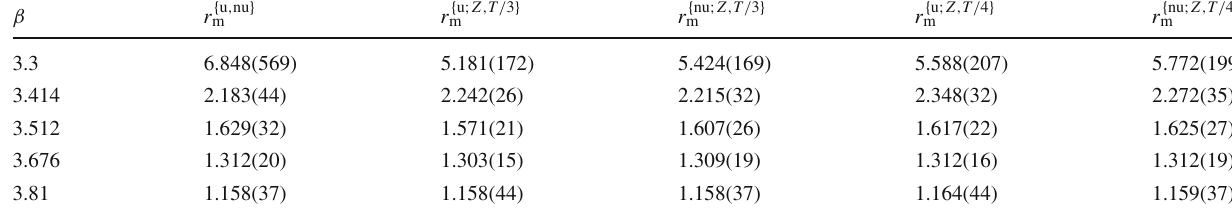
Fig. 6 Left: results for different r m estimates as reported in Table 4. The results for β = 3 . 3 are not shown. Right: ratio of different r m determinations as a function of the squared lattice spacing. The dashed horizontal line indicates the expected continuum result